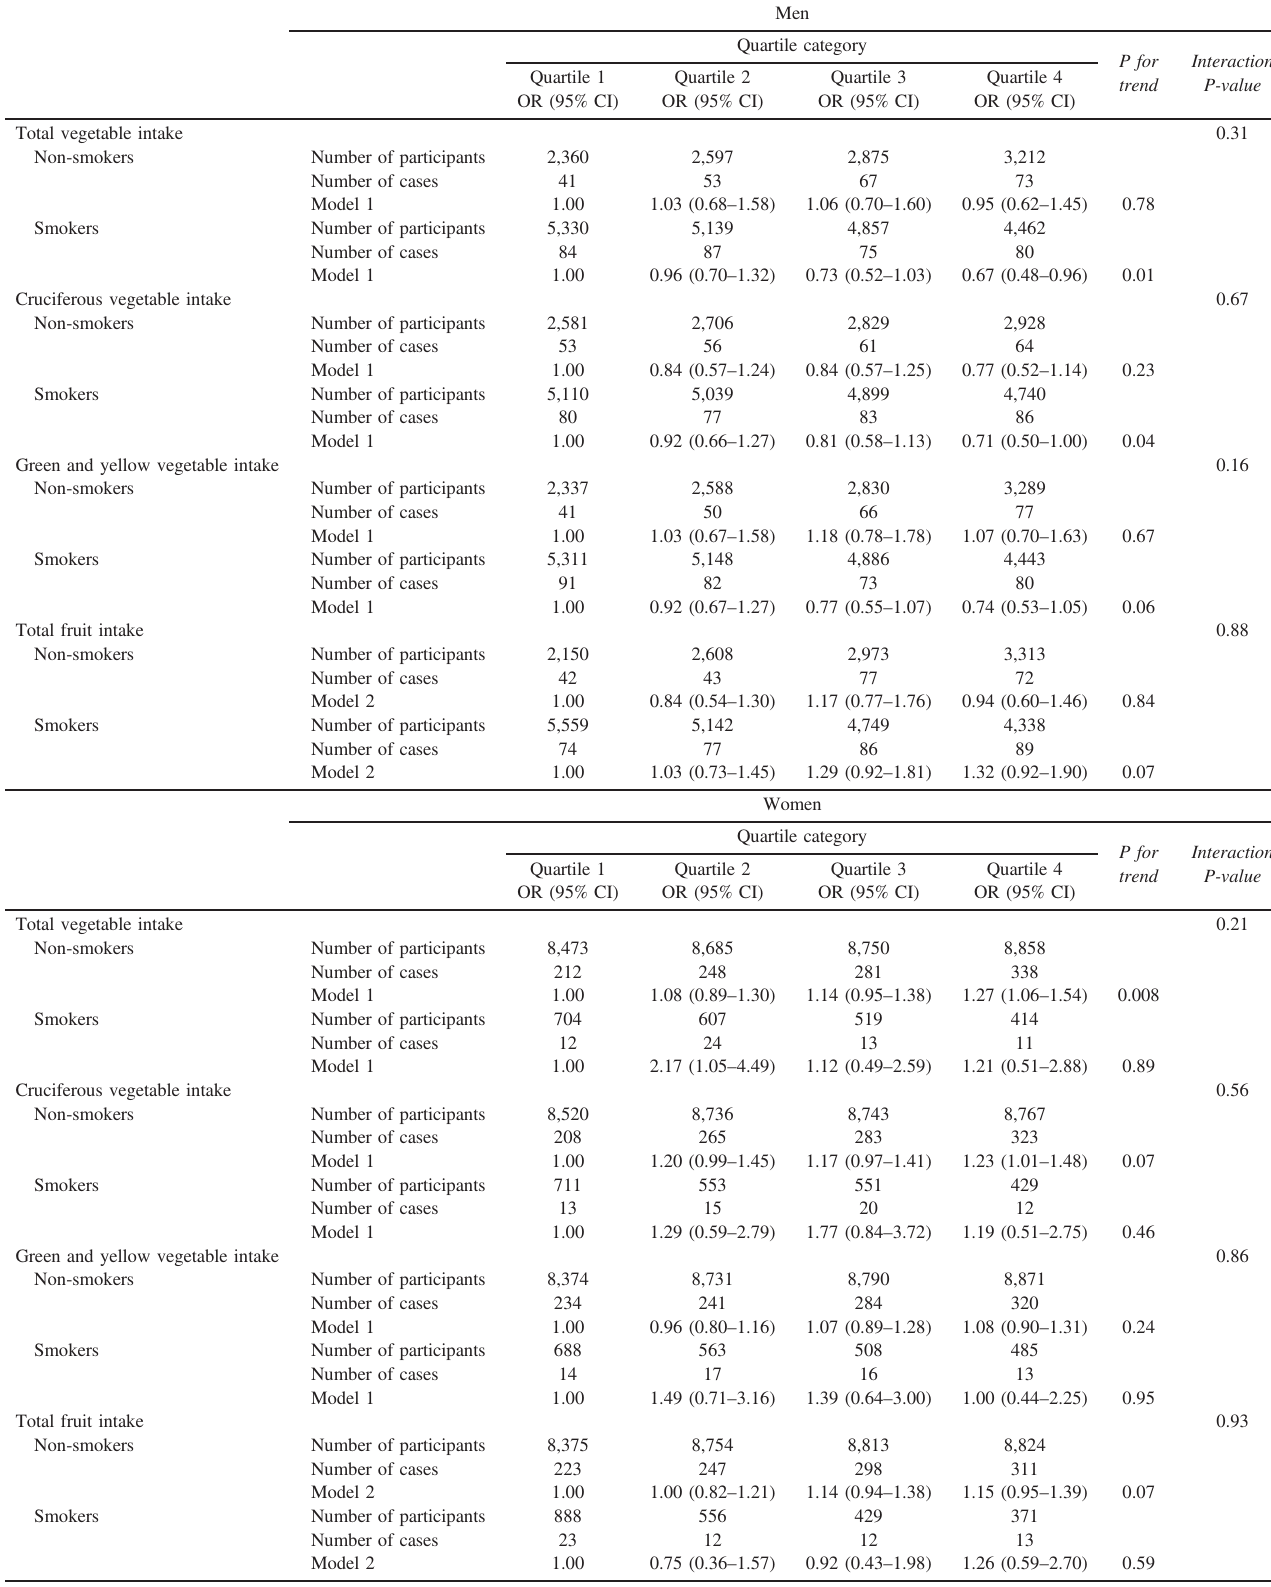
Table 3. Multivariate odds ratios for cataract incidence according to total vegetable, cruciferous vegetable, green and yellow vegetable, and fruit intake category in men and women by smoking